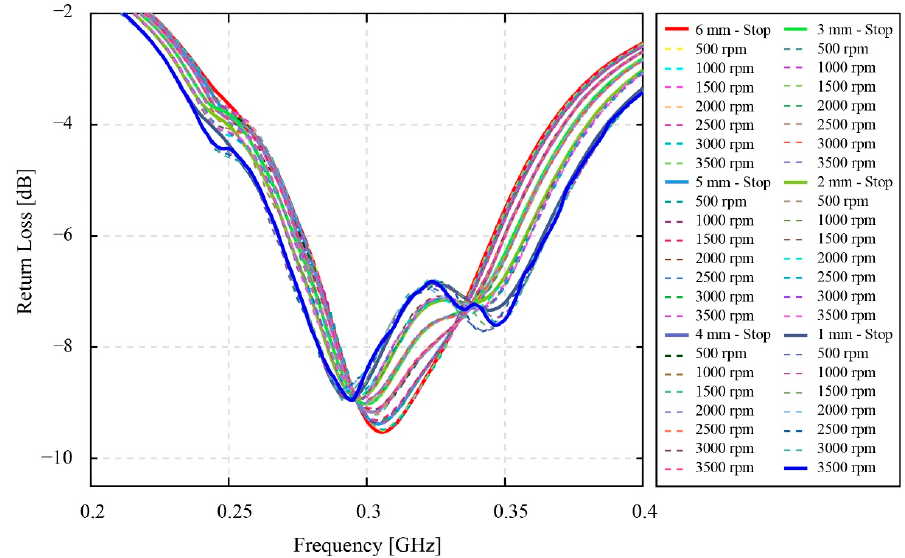
Figure 15. The effect of phase fluctuation at the high speed of the smart gear (limited to the vicinity of 0.3 [GHz] valley).